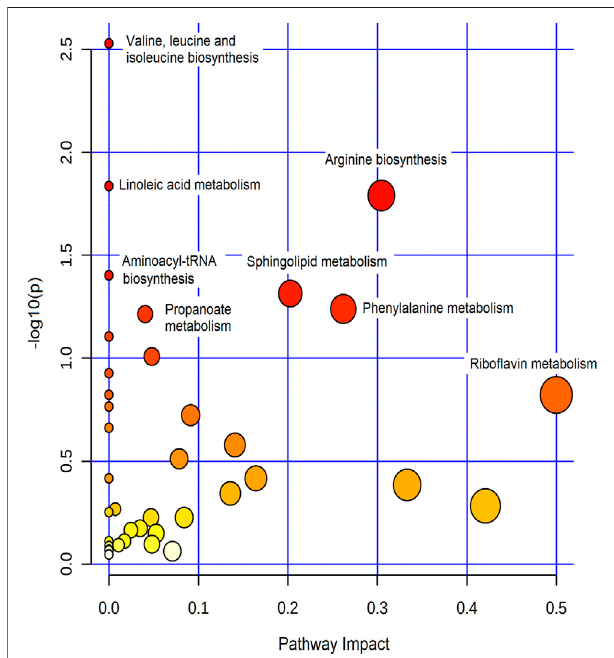
FIGURE 3 | Summary of the most affected pathways. The node color andsizearebasedonthe p -valueandthepathwayimpact value,respectively.